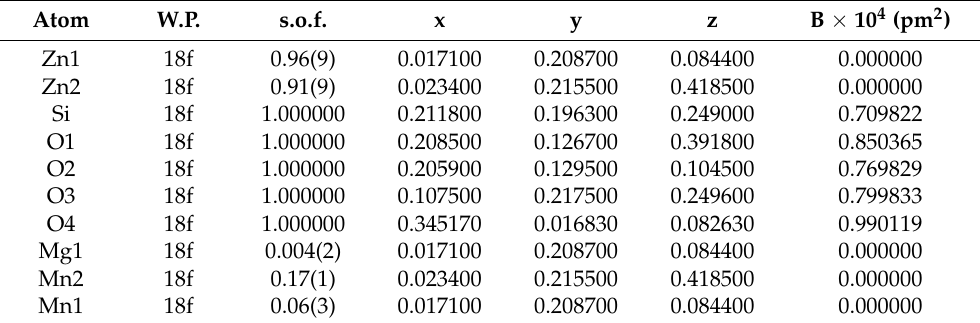
Table 5. Refined structural parameters for W2 sample Zn 1.77 Mn 0.20 Mg 0.01 ) ∑ 1.98 Si 1.01 O 4 obtained from the Rietveld refinement using X-ray powder diffraction data at room temperature. Atom